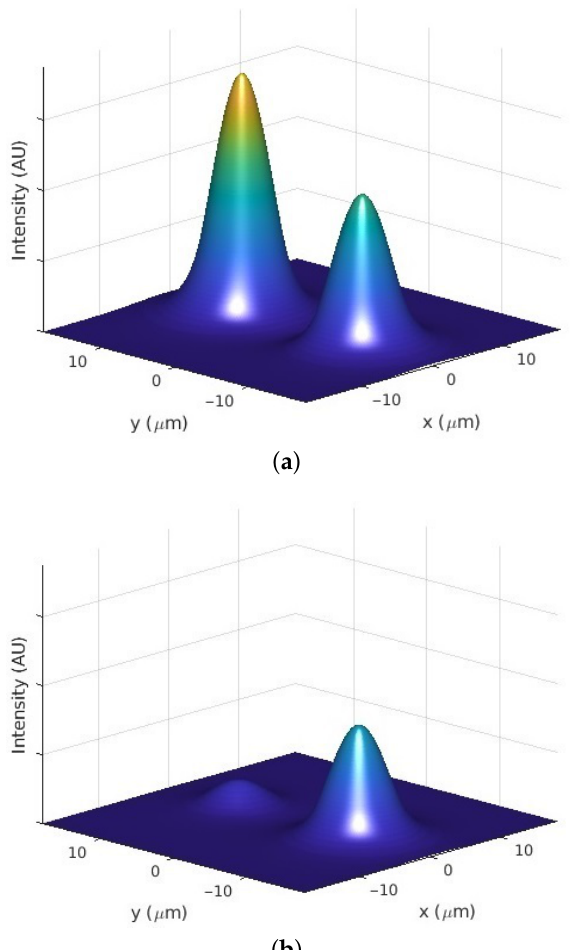
Figure 6. The spatial variation of the circularly-polarised components of the intensity, defined by (73) for pump ellipticities of P ( 1 ) = 0 and P ( 2 ) = 1 with a total normalised pump power in each guide ( i ) + η ( i ) = 100. Guide ( 2 ) is to the left in the diagrams (in the positive y direction). of η ( i ) = η + −